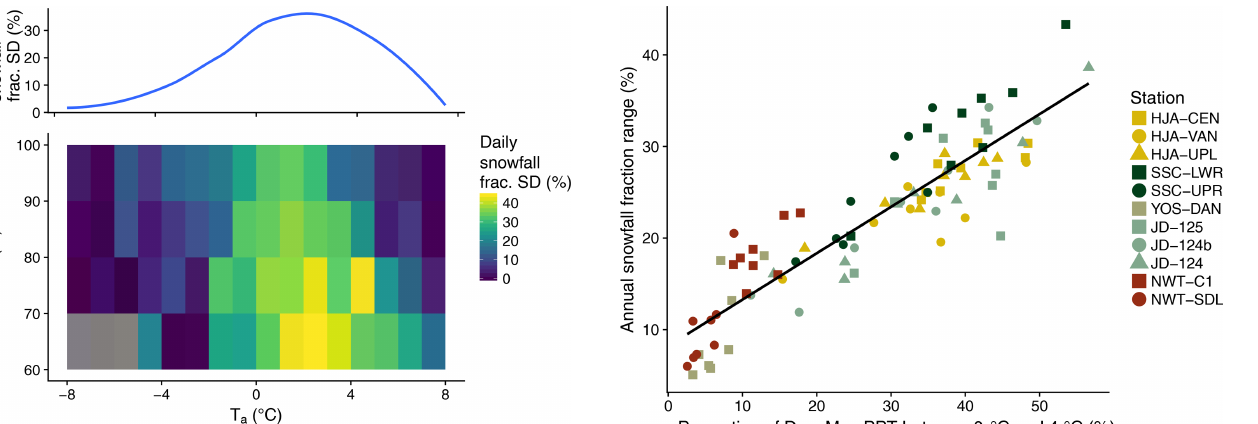
Figure 11. Range in annual snowfall fraction as predicted by the proportion of December–May PPT falling between 0 and 4 ◦ C. Each point represents one simulation year at a station identified by the color and shape. The black line of best fit was calculated using or- dinary least-squares regression ( r 2 = 0 . 80; p value < 0 .